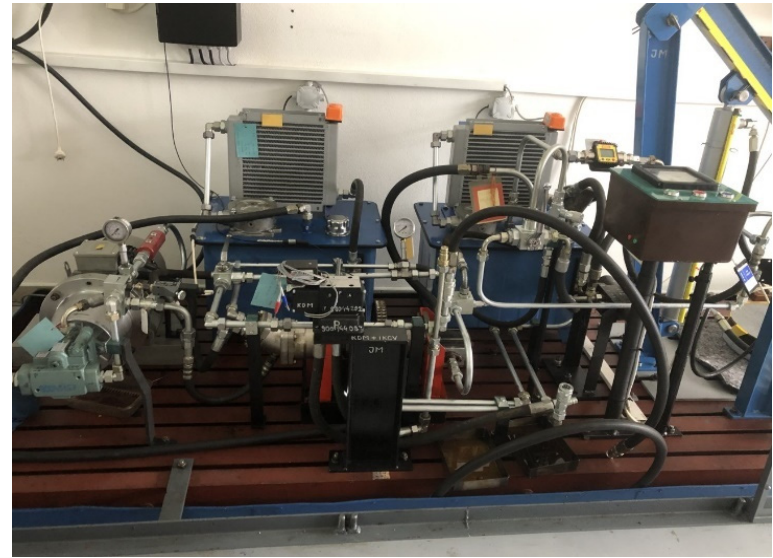
Figure 2. Laboratory equipment for measuring the parameters of hydrostatic transducers.